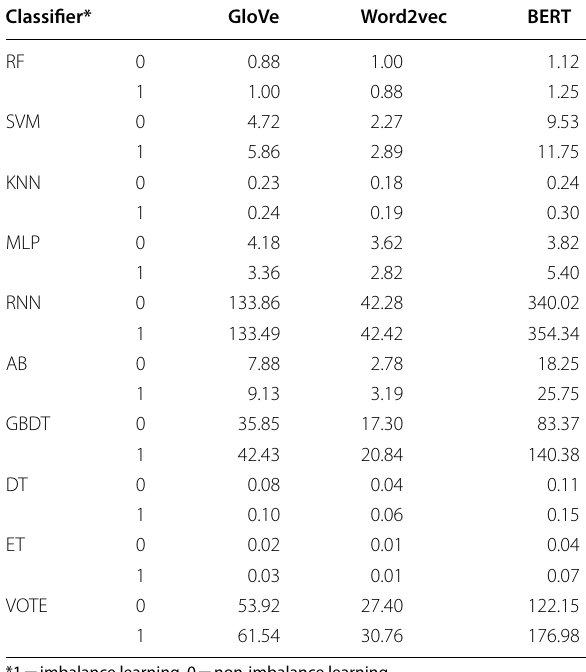
Table 14 The training time with and without imbalance learning (s)